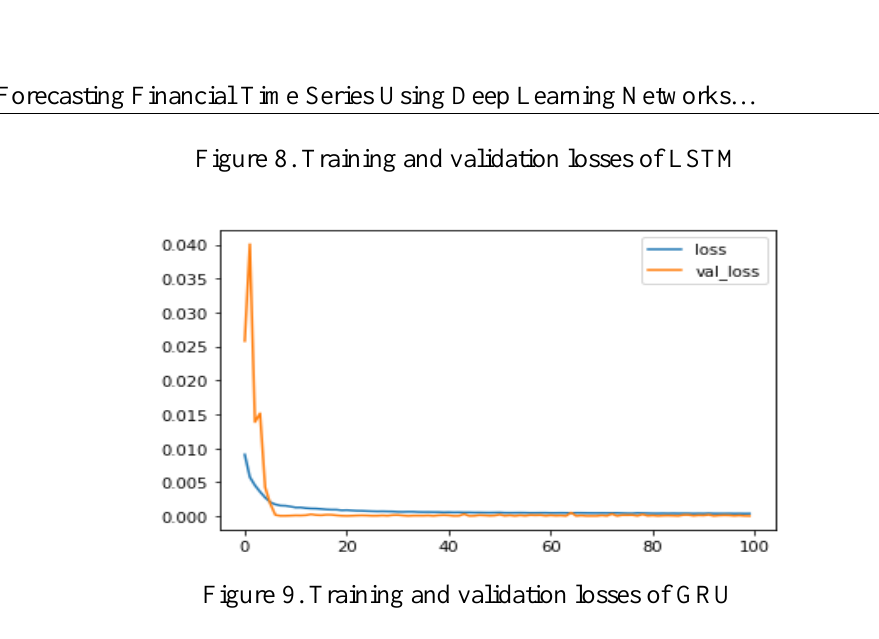
Figure 9. Training and validation losses of